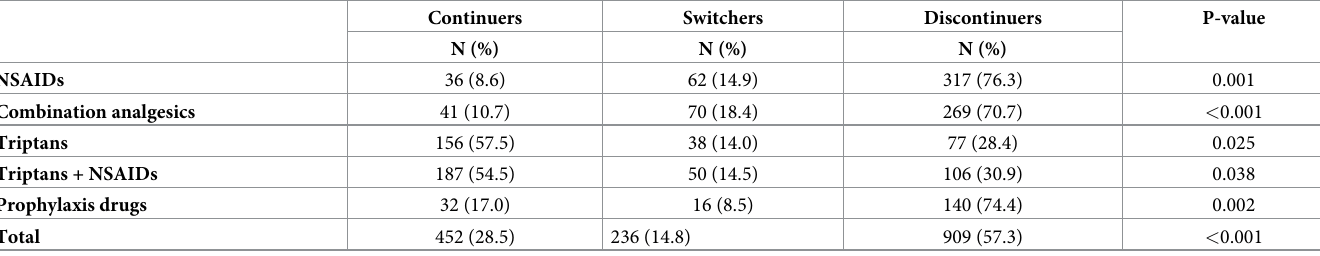
Table 4. Persistence patterns of different class of anti-migraine drugs.